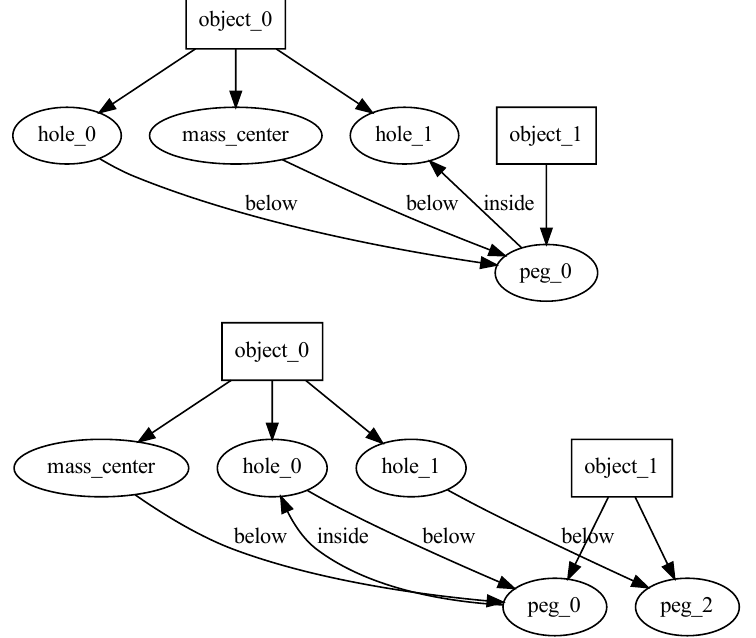
Figure 3. Scene descriptions in the form of a graph of feature relations. They correspond to the point clouds depicted in Figure